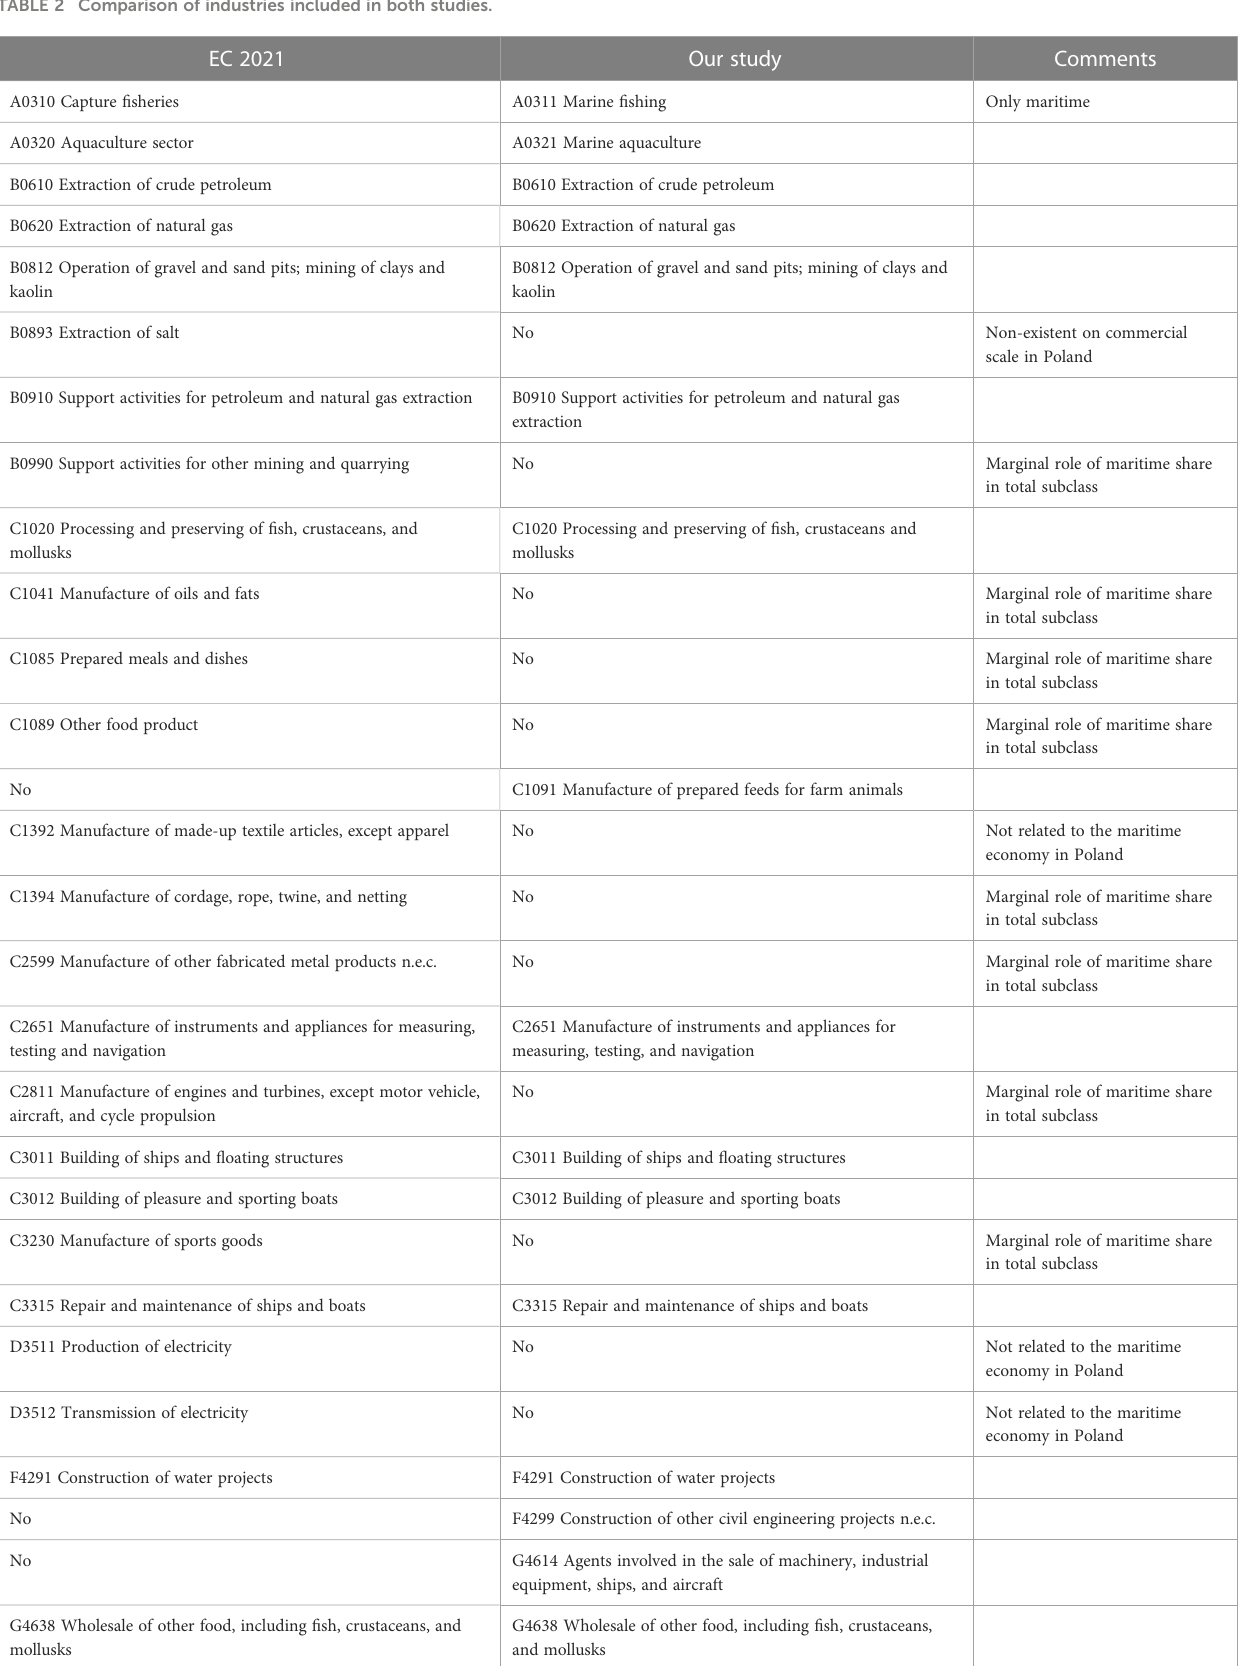
TABLE 2 Comparison of industries included in both